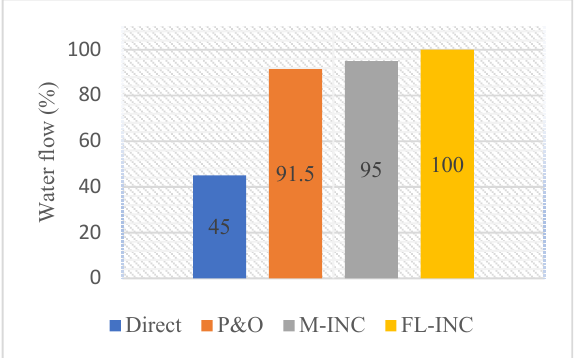
Figure 17. Water flow pumped from different techniques.